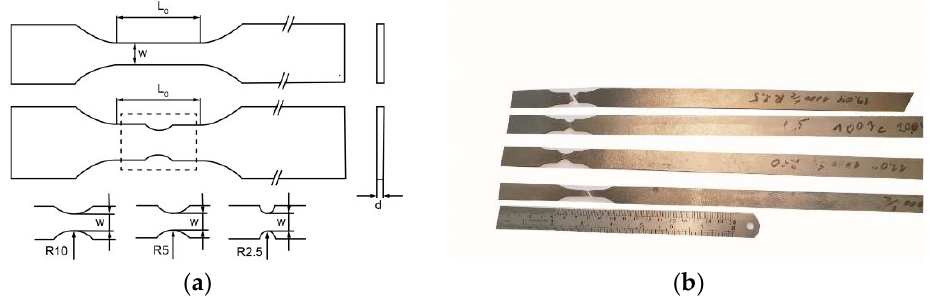
Figure 1. ( a ) Schematic geometry of smooth and notched specimens; ( b ) photos of specimens after testing.